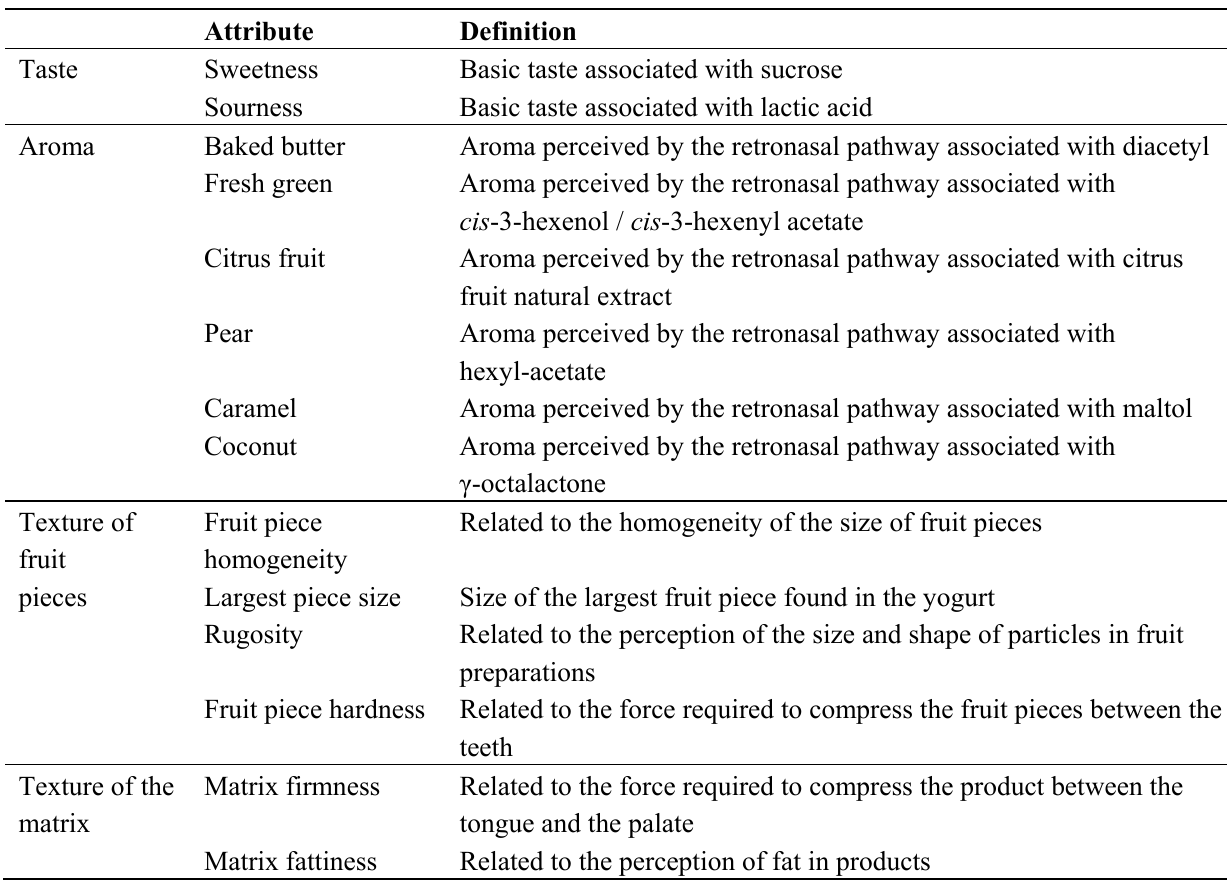
Table 7. List of attributes used for the sensory profile and their